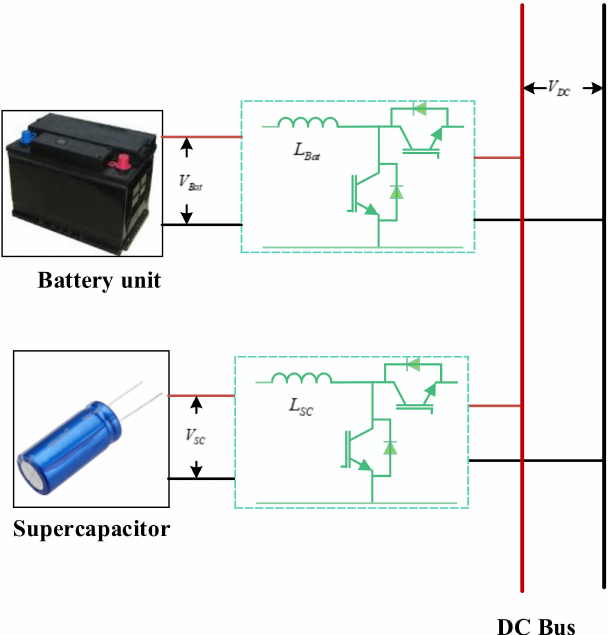
Figure 3. Hybrid energy storage system (battery and supercapacitor) connected to DC-Bus. Inertia Provided by